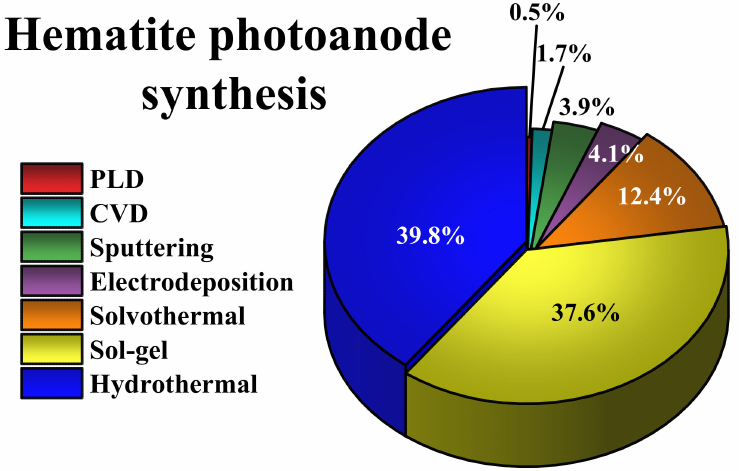
Figure 2. Publications found in the Scopus database, using the search term “hematite photoanode synthesis” and the topics enlisted in the legend from 2000 to 2021 (as of January